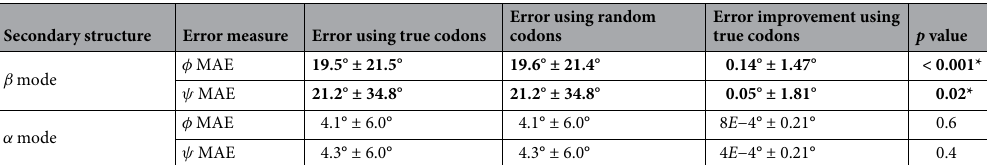
Table 1. True synonymous codon information reduces the prediction error of backbone dihedral angles. Significant results ( p value < 0.05 ) are indicated with *. Significant values are in